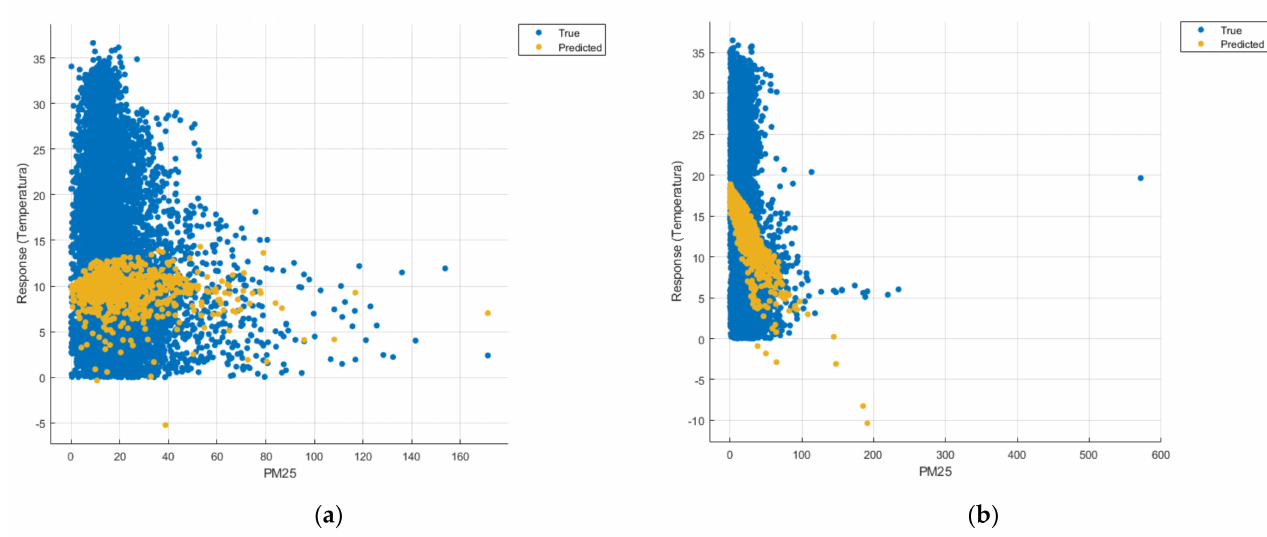
Figure 12. Prediction considering only PM2.5—Linear Regression. ( a ) March 2019–February 2020, ( b ) March 2020– February 2021.